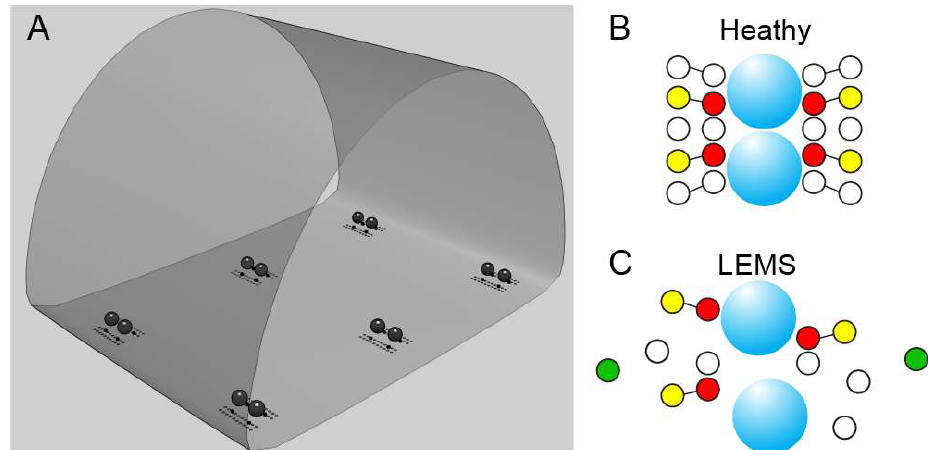
Figure 4. Diagrams of MCell models that can be constructed of mouse AZs in healthy and LEMS conditions. ( A ) Diagram of a mouse NMJ MCell model environment that contains 6 AZs. The 3- dimensional enclosure depicts a portion of the motor nerve terminal with black spheres representing docked synaptic vesicles within each AZ. Dots adjacent to the docked synaptic vesicles represent AZ proteins (gray dots) and P/Q-type VGCCs (black dots). ( B ) Diagram of a hypothesized healthy AZ based on predictions for the number and position of docked synaptic vesicles (blue spheres), P/Q VGCCs (red circles), calcium-activated potassium channels (yellow circles), and other unknown AZ proteins (white circles). ( C ) Diagram of a hypothesized LEMS AZ based on predictions for the number and position of docked synaptic vesicles (blue spheres), P/Q VGCCs (red circles), calcium-activated potassium channels (yellow circles), L-type VGCCs (green circles), and other unknown AZ proteins (white circles). Panel A is modified from Laghaei et al. [5].